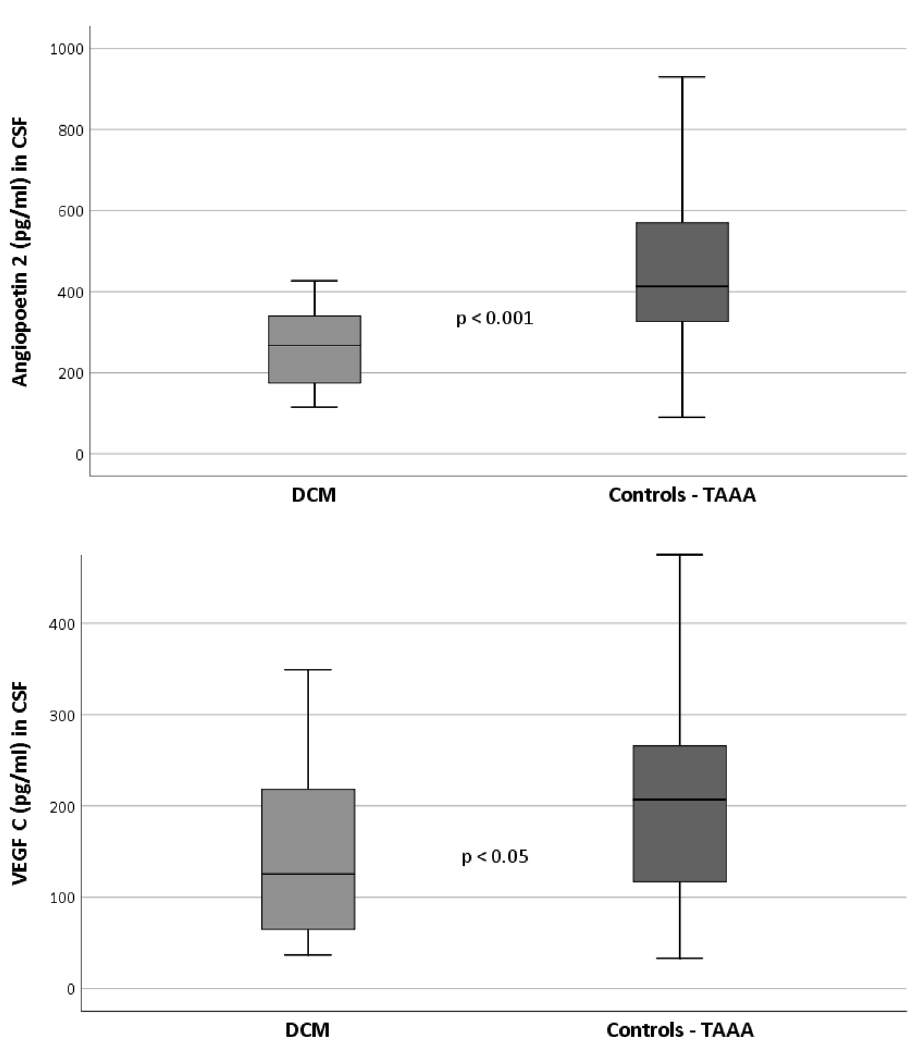
Figure 3. Significant differences of mediator concentrations (Angiopoietin 2 and VEGF C (pg/ml)) in CSF of DCM group and controls. CSF cerebrospinal fluid, DCM Degenerative cervical myelopathy, pg/ml picogram/ milliliter. Italic values indicate significance level of p <